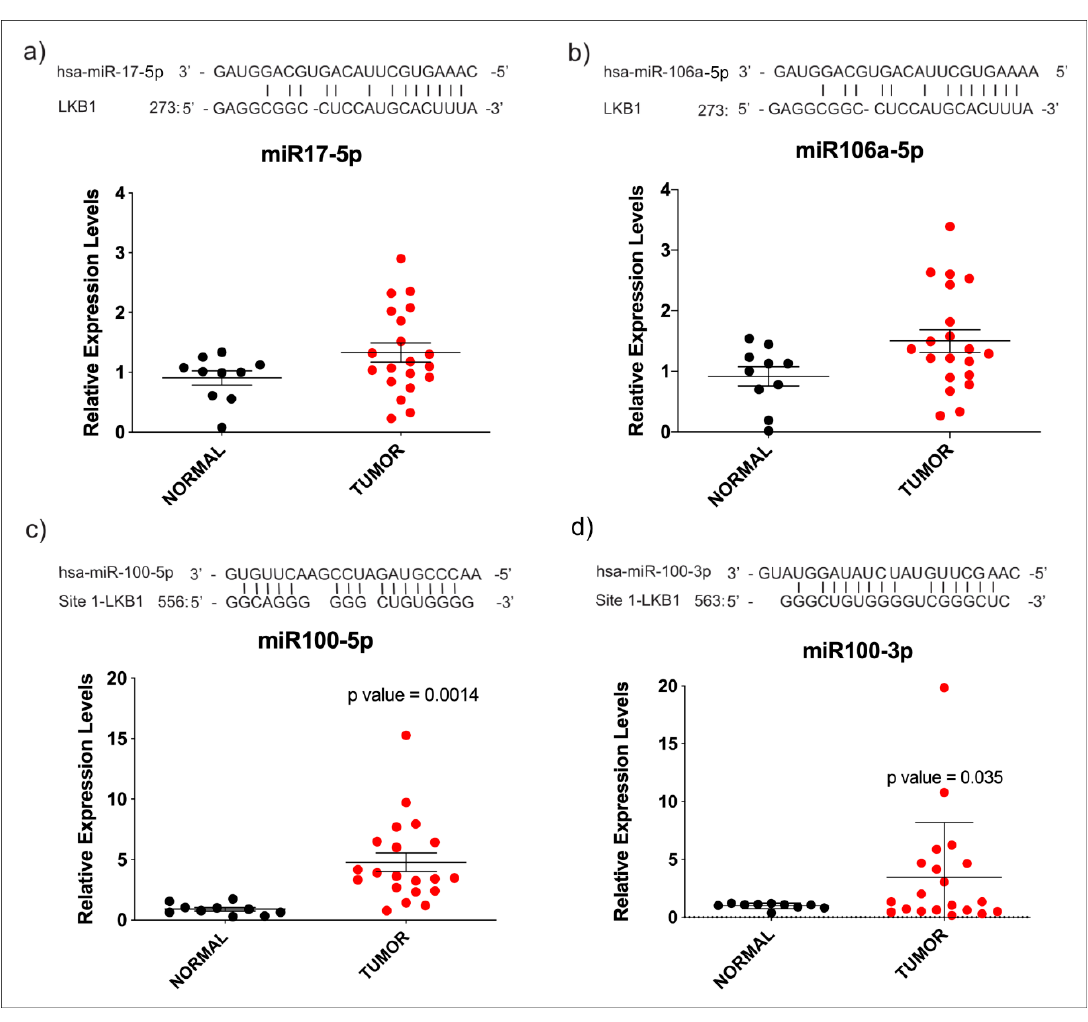
Figure 3. miRNAs relative expression in HNC patients. Relative expression of miR ‐ 17 ‐ 5p ( a ), miR ‐ 106a ‐ 5p ( b ), miR ‐ 100 ‐ 5p ( c ) and miR ‐ 100 ‐ 3p ( d ) in HNC samples versus normal adjacent tissue. Seed regions of 3 ′‐ UTR of STK11 are depicted for each miRNA (upper sequence). The statistically significant difference is indicated by p ‐ values.